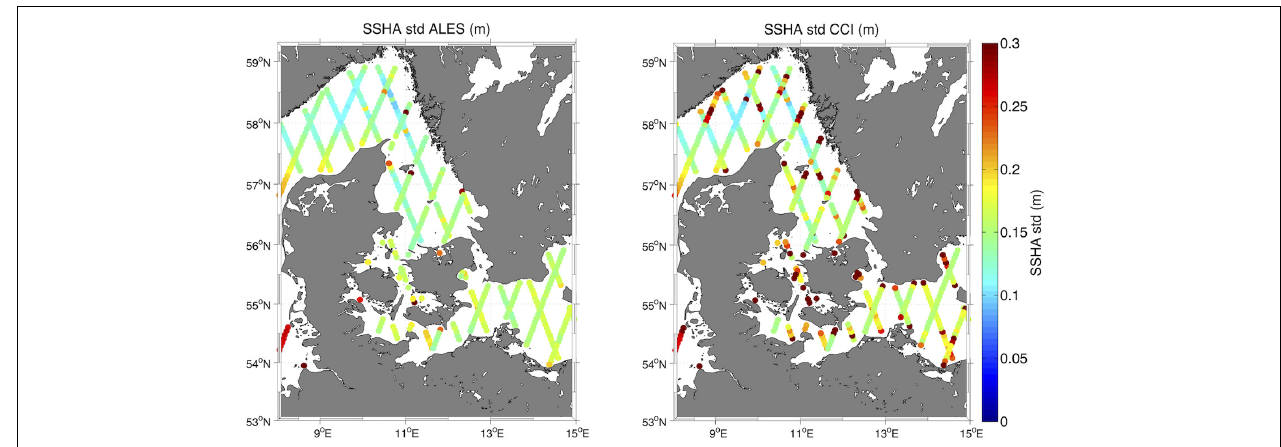
FIGURE 4 | Comparison between (Left) ALES reprocessed and (Right) Envisat SL_cci data sets in terms of standard deviation of the Sea Surface Height Anomaly time series for each 1 Hz location (adapted from Passaro et al., 2015a, with permission).